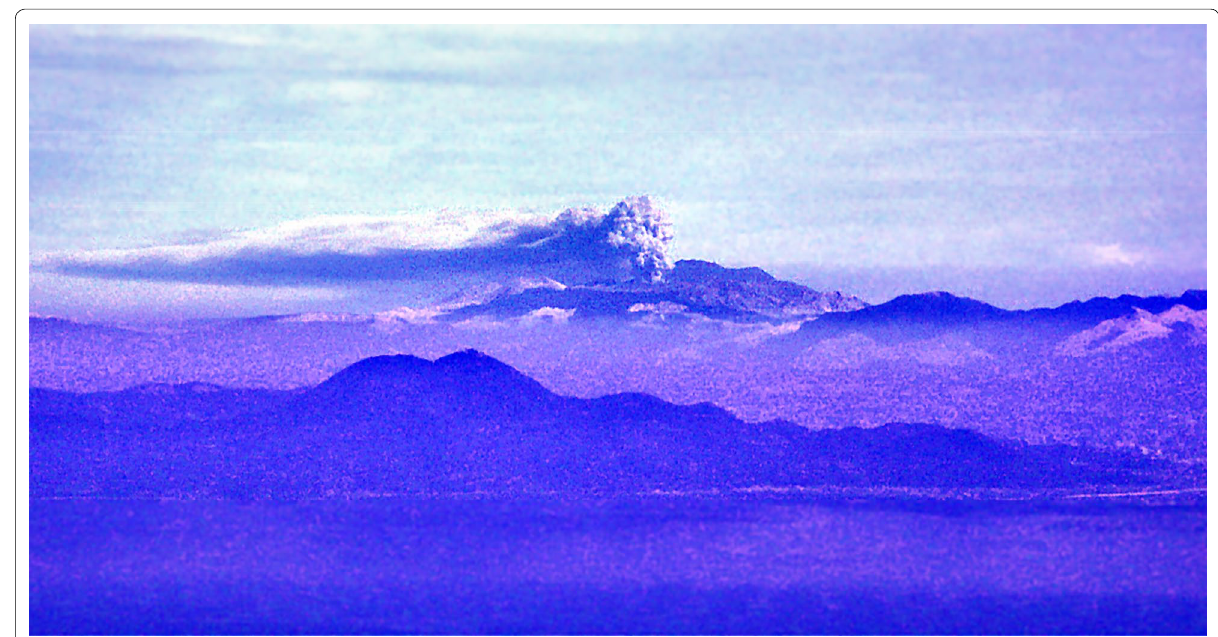
Fig. 2 The active ash-plume above Nakadake on January 18, 2015, during a period of sustained Strombolian activity. The plume reaches approxi- mately 600 m above the active crater. Photograph taken from Unzen volcano looking ENE along the Bebbu–Shimabara graben. In the